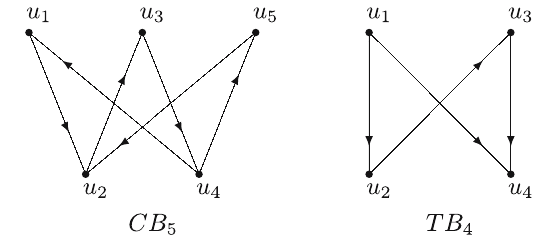
Figure 5: Two bipartite tournaments CB 5 and TB 4 .